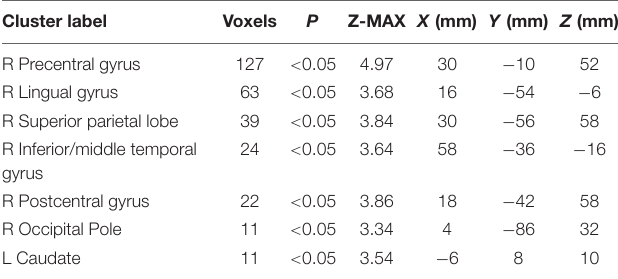
TABLE 2 | Interaction of diagnosis and reactive aggression.